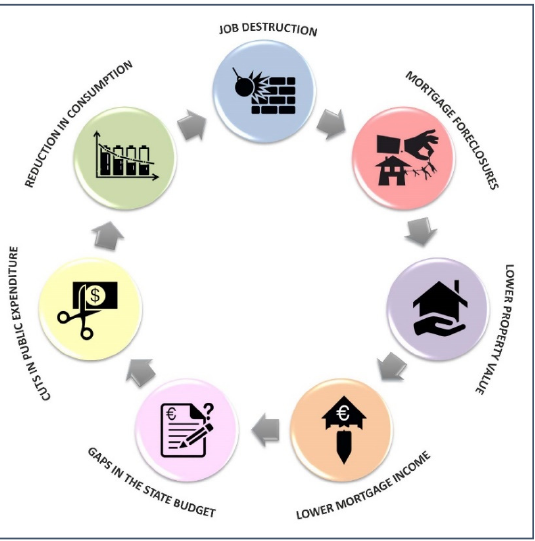
Figure 3. Factors conditioning the economic housing crisis in Spain (2008–2015). Source: author’s elaboration.